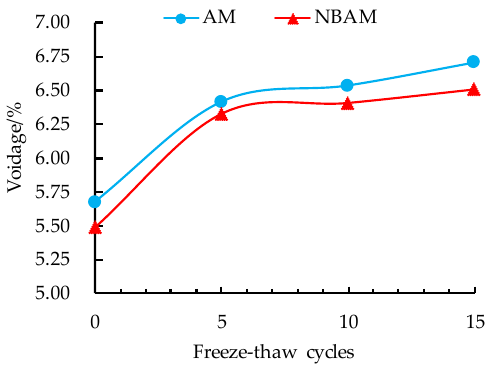
Figure 7. Variation of porosity of asphalt mixtures under freeze‒thaw cycles.